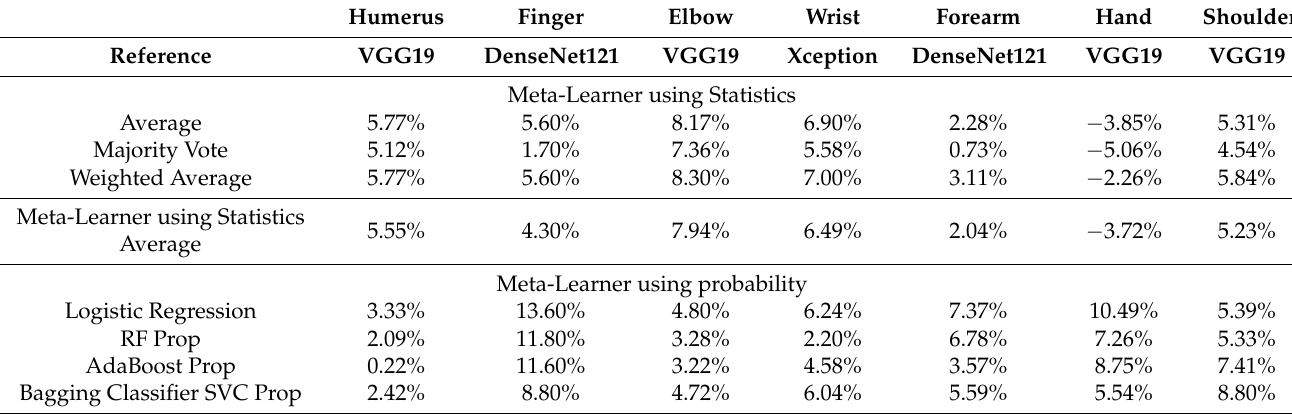
Table A8. The percentage difference between the Kappa score of the highest level-0 classifiers (CNNs) to the Kappa score of the level-1 classifiers (machine learning algorithms). Test performance is